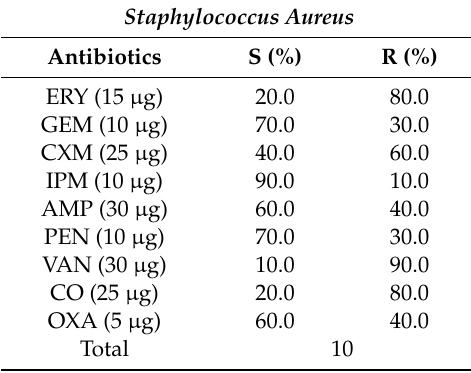
Table 2. Antibiotic susceptibility pattern of S. aureus (gram positive) (S—Sensitive,